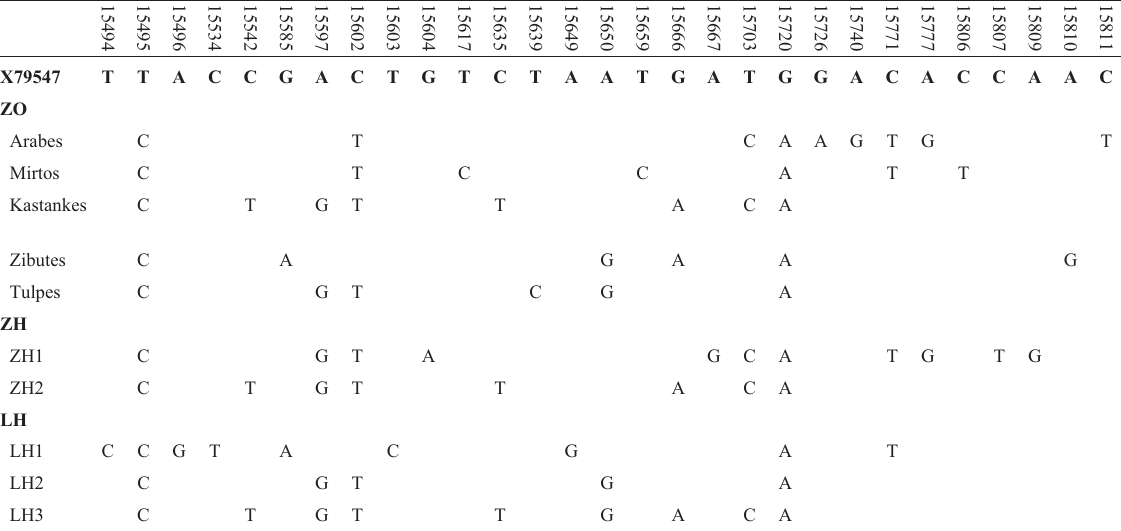
Table 1 - Polymorphic sites of Zemaitukai horse breed family lines and reference (GeneBank X79547) in control region of horse mtDNA D-loop sequence. See text for